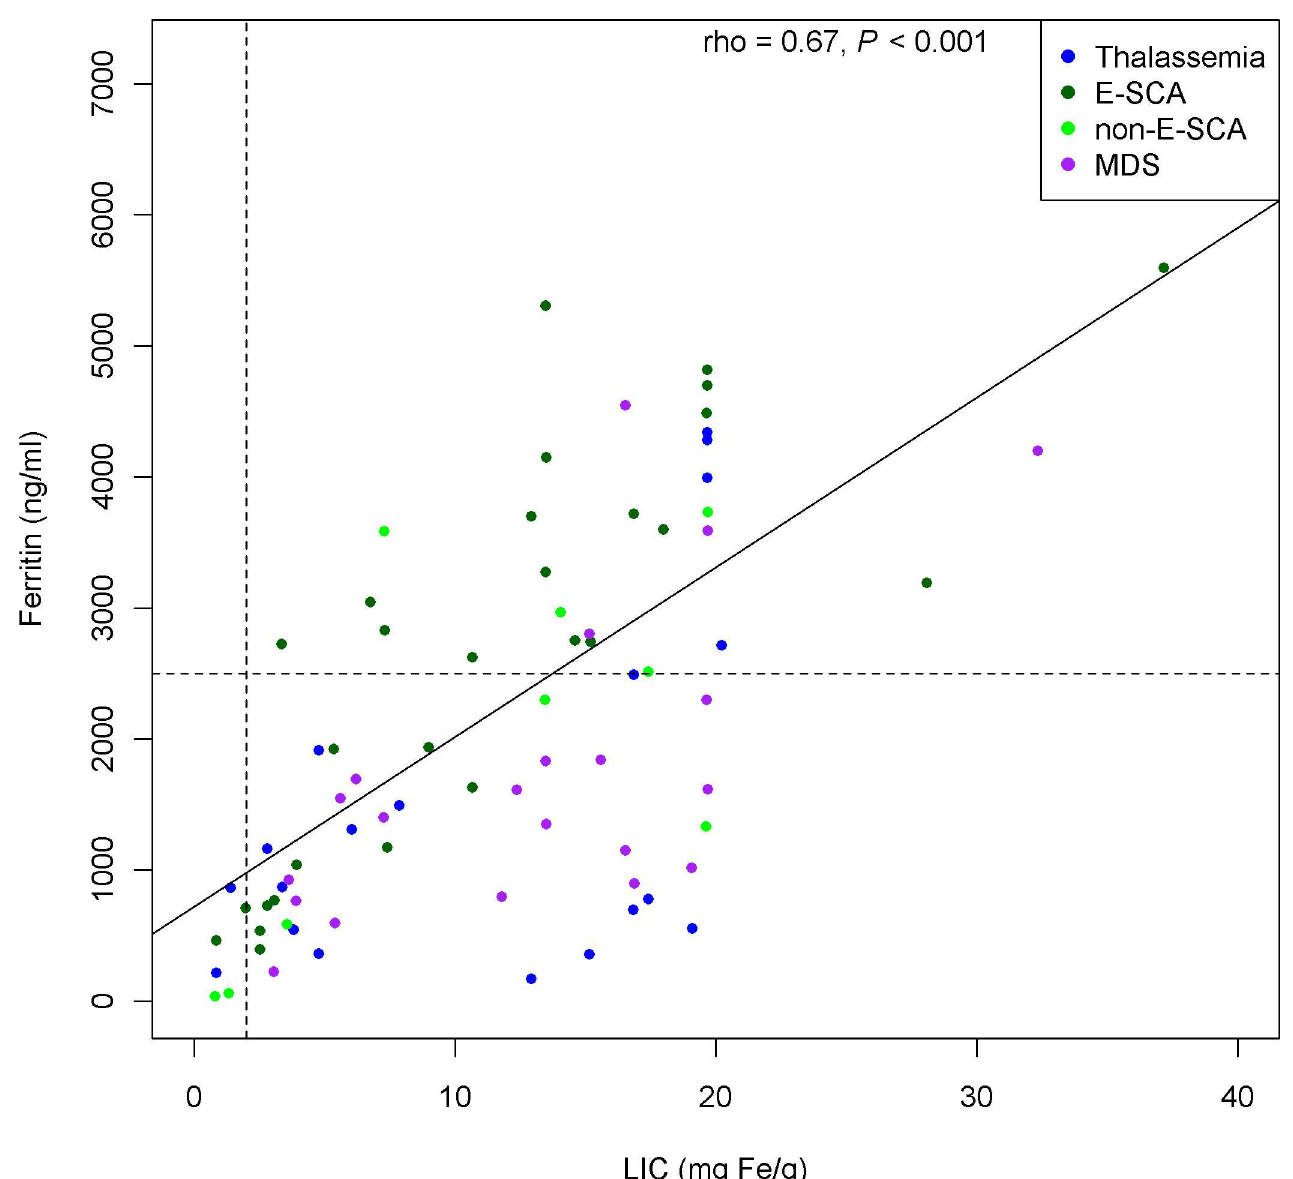
Fig 1. association between ferritin and liver iron content in the global